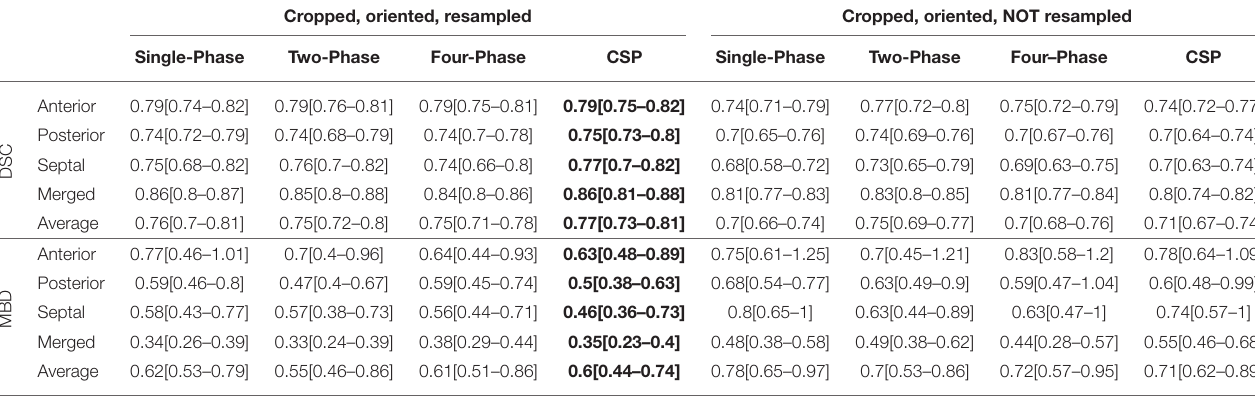
TABLE 2 | Inference Results Using Annular Curve Input across all stages of repair.